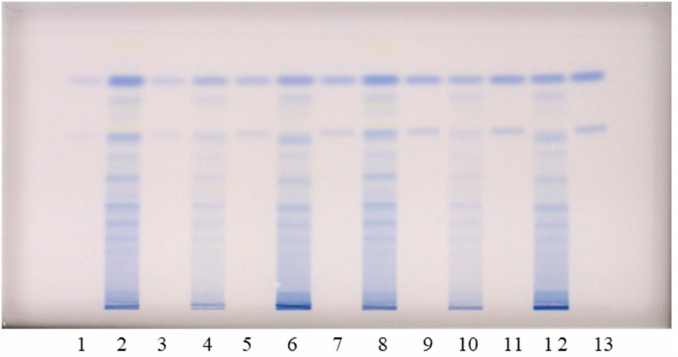
Figure 3. HPTLC chromatograms used for the quantitative determination of proanthocyanidins in STSs from rhizomes (1 µ L, 50 mg/mL) of Japanese (tracks 2 and 8), Bohemian (tracks 4 and 10) and giant (tracks 6 and 12) knotweed and standard solutions of ( − )-epicatechin and procyanidin B2. The HPTLC silica gel plate was developed with toluene–acetone–formic acid (3:6:1, v/v ) and documented at white light after derivatization with DMACA detection reagent. The applications of ( − )-epicatechin and procyanidin B2 standard solutions: track 1: 30 ng; track 3: 40 ng; track 5: 60 ng;